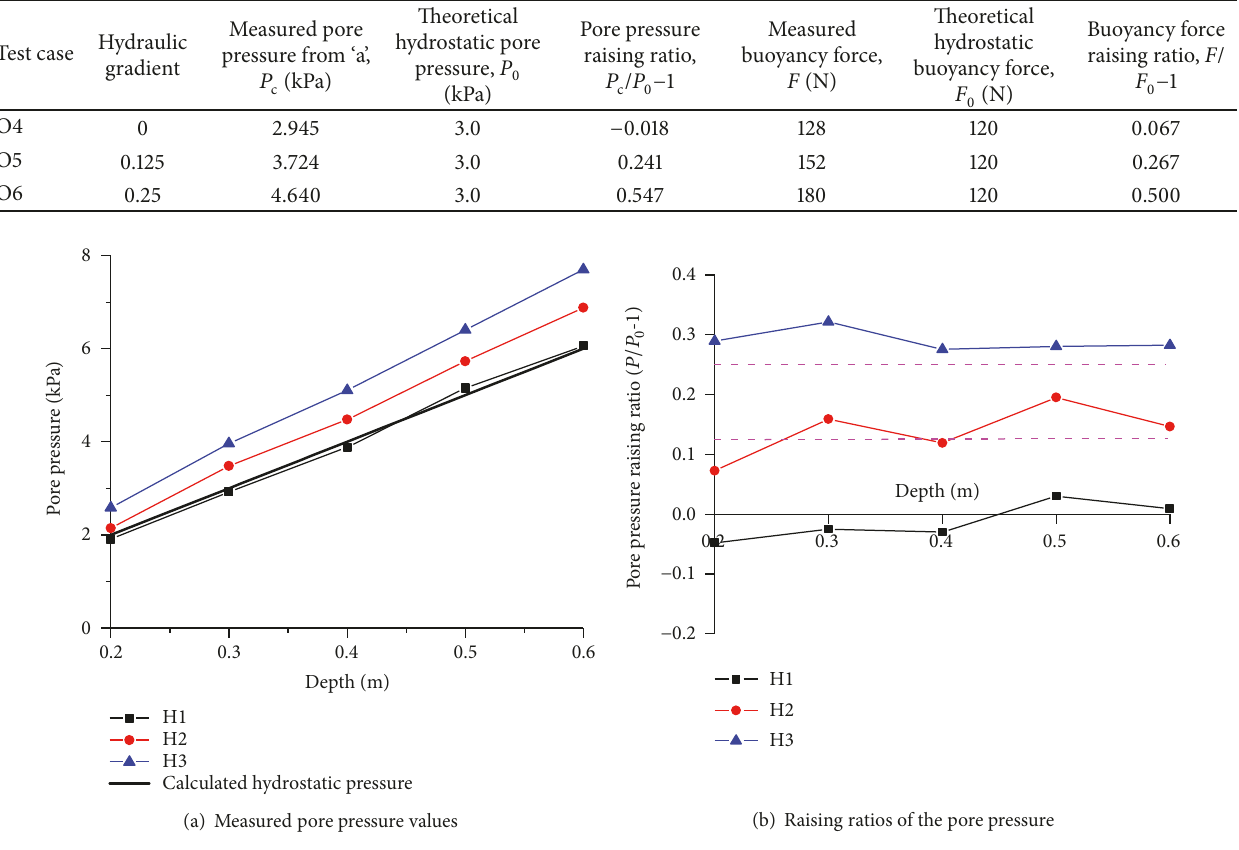
Figure 6: Measured pore pressure at different depths in structural corner